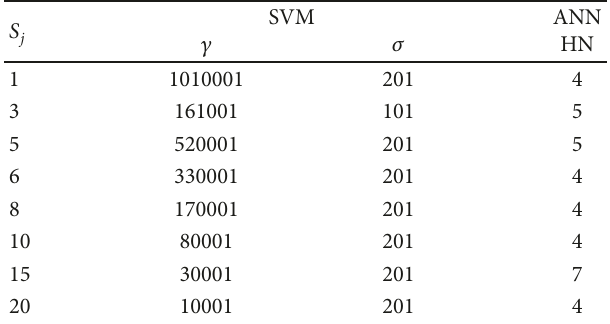
Table 4: Parameters for the Great Salt